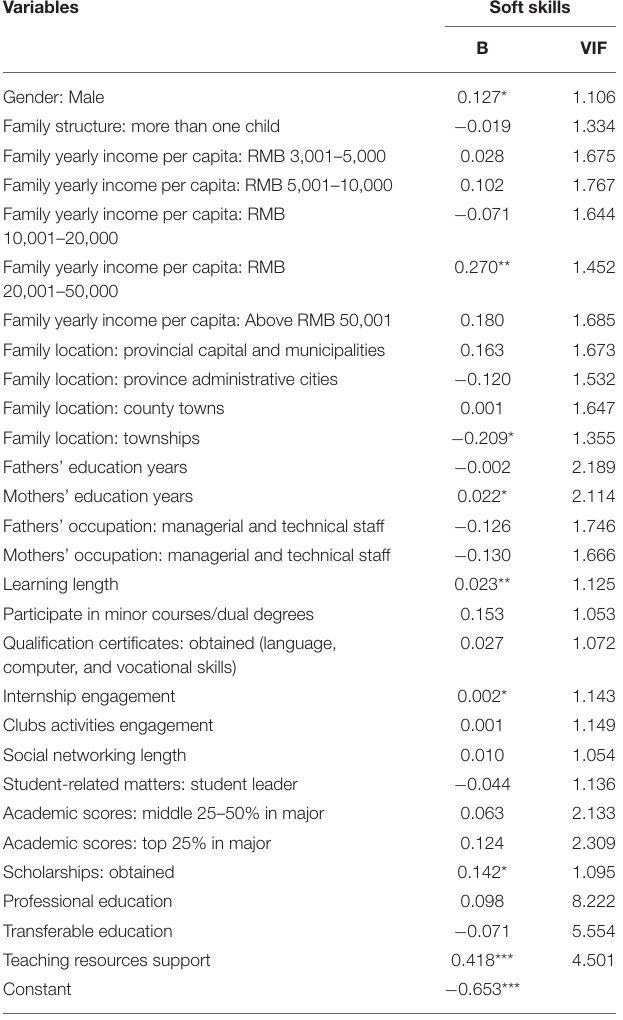
TABLE 5 | Factors impact on finance and trade graduates’ soft skills. Variables